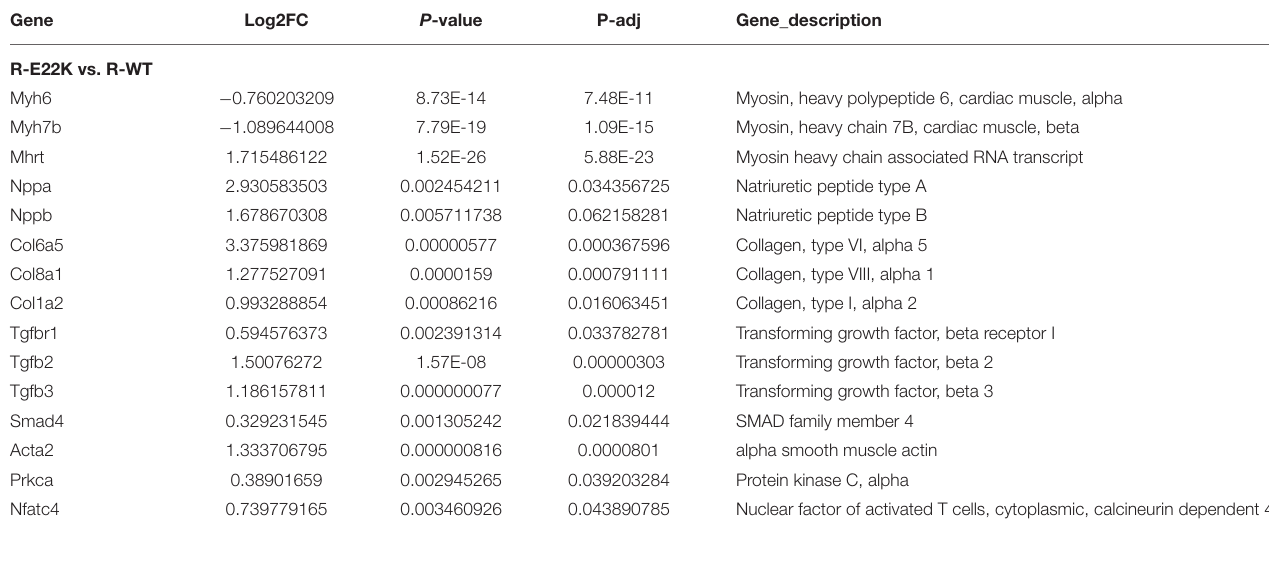
TABLE 2 | Changes in gene expression profiles in the left ventricle of E22K mutant mice. Gene Log2FC P -value P-adj Gene_description